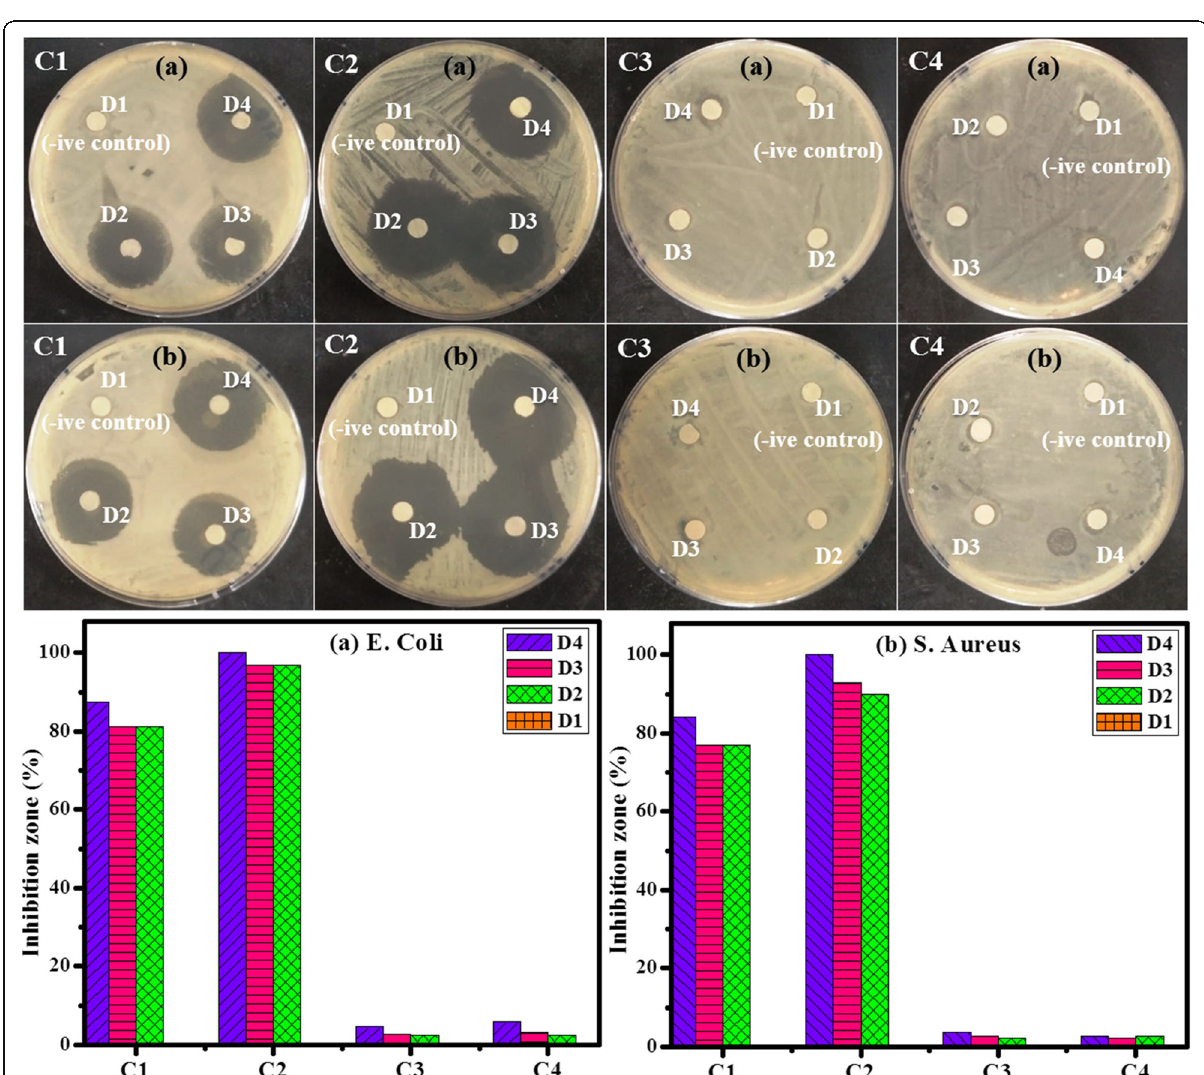
Fig. 9 Disk diffusion assay and qualitative antibacterial assessment of C1, C2, C3 and C4 against ( a ) Escherichia coli and ( b ) Staphylococcus